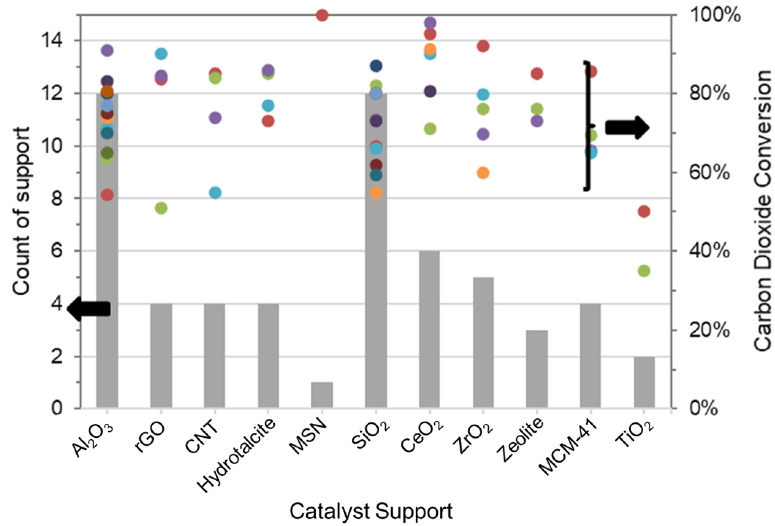
Figure 4. Literature survey plot for catalyst support and their CO 2